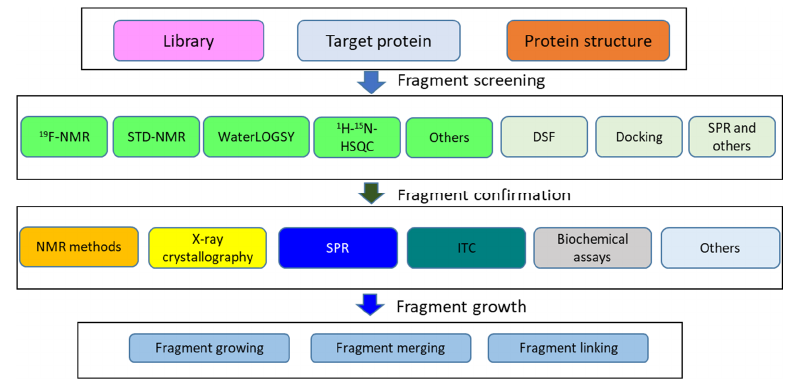
Figure 3. Flowchart of FBDD. A summary of FBDD is given. To start a fragment screening, a compound library and a purified target protein are required. For computational-based screening, the protein structure is needed. NMR plays important roles in fragment screening and hit confirmation. NMR experiments are highlighted in green. “Others” includes experiments such as relaxation-based NMR experiments, SLAPSTIC, etc. (Table